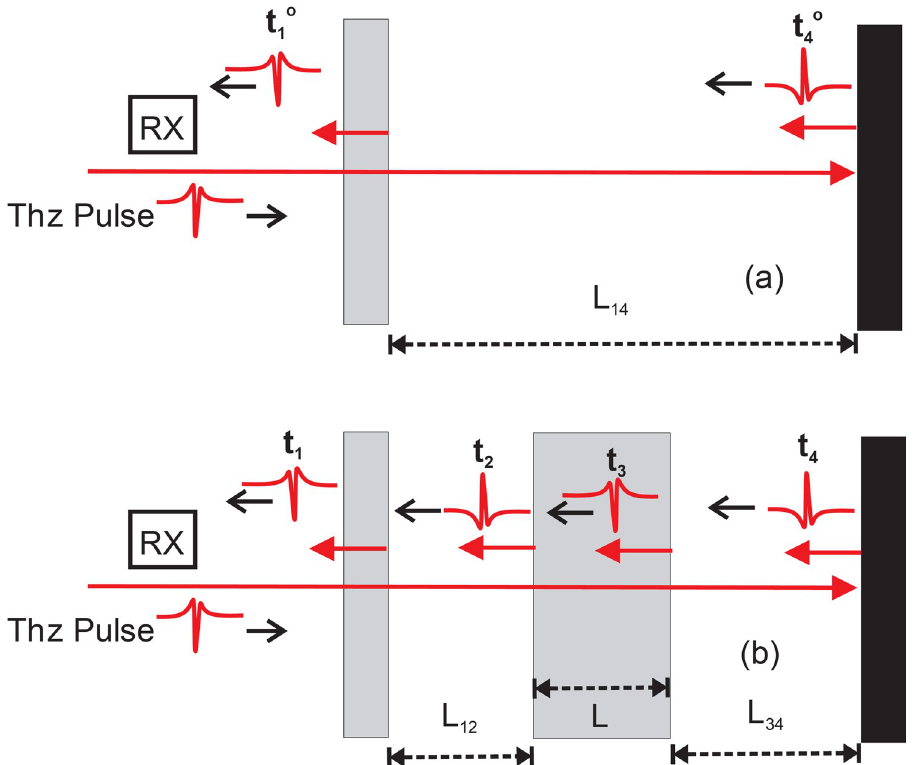
Fig 2. Illustration of the external reference structure for simultaneous determination of sample thickness and refractive index. (a) configuration for determining distance L pulses from back surface of beamsplitter, front surface of sample, back surface of sample, and reflecting mirror.